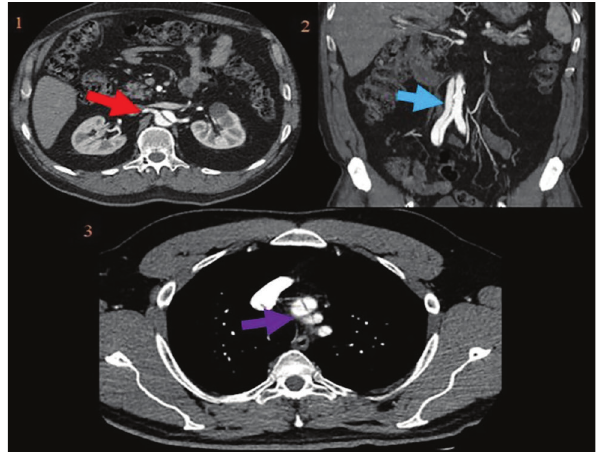
Figure 2 - Lumen formation demonstration (1: False lumen at right renal artery, 2: Both true and false lumen at right common iliac artery, 3: Both true and false lumen at brachiocephalic artery, right common carotid artery and left subclavian